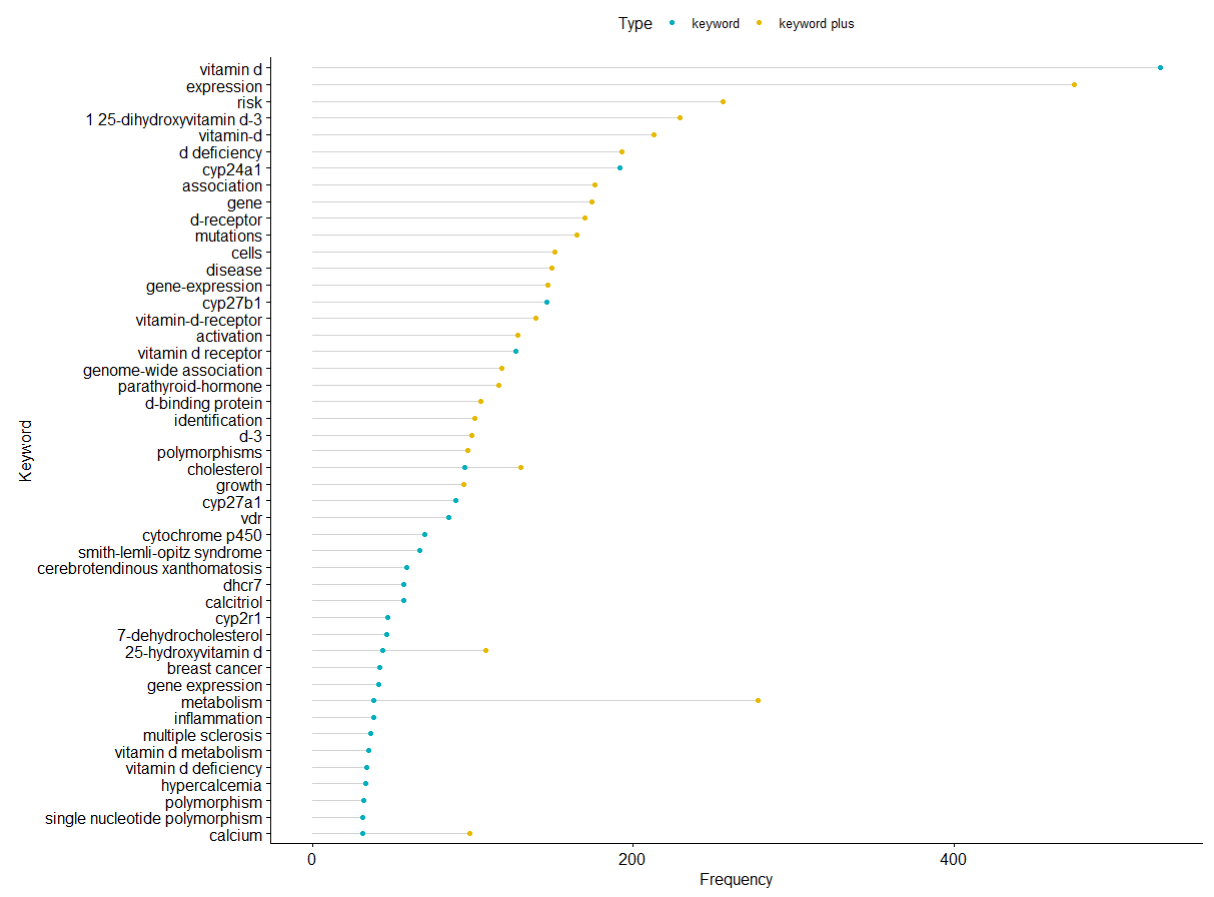
Figure 6. Top frequent 25 keywords and keywords plus. Table 3. The main vitDMGPs research topics according to keywords.